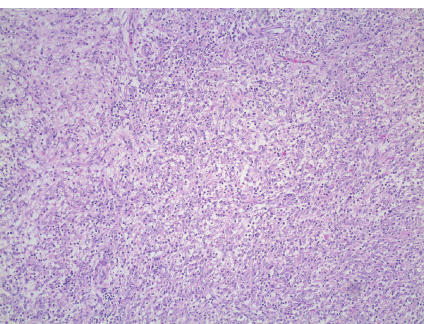
Figure 3: Histologic image of IMT showing chronic inflammatory cells (lymphocytes, plasma cells, and histiocytes) as well as spindle- shaped cells with pale eosinophilic cytoplasm and plump; no atypia were noticed (H/E magnification ×